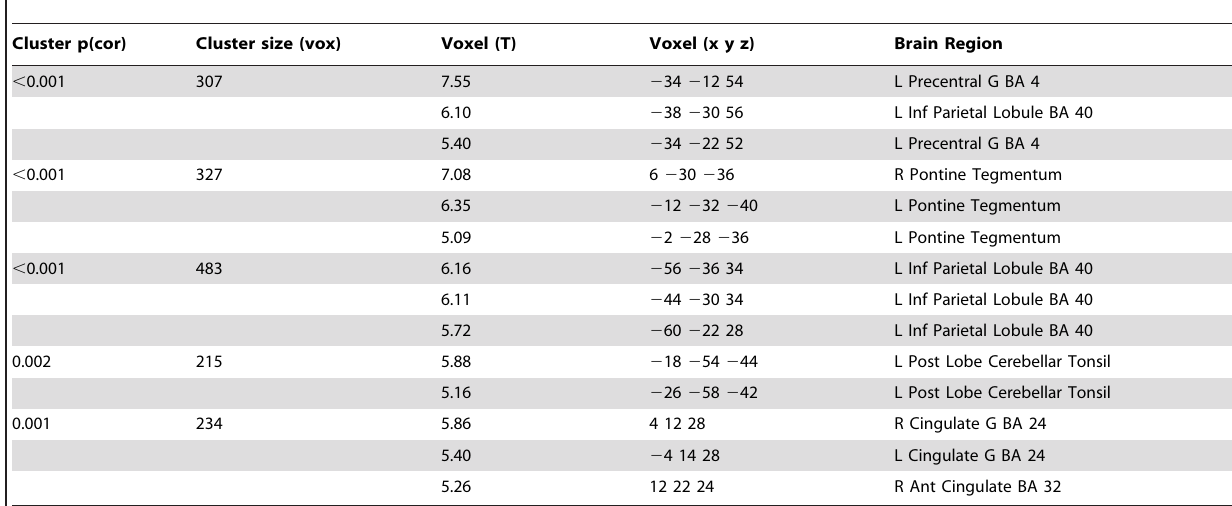
Table 2. Significant connectivity peaks for the contrast of moderate sedation vs. awake.